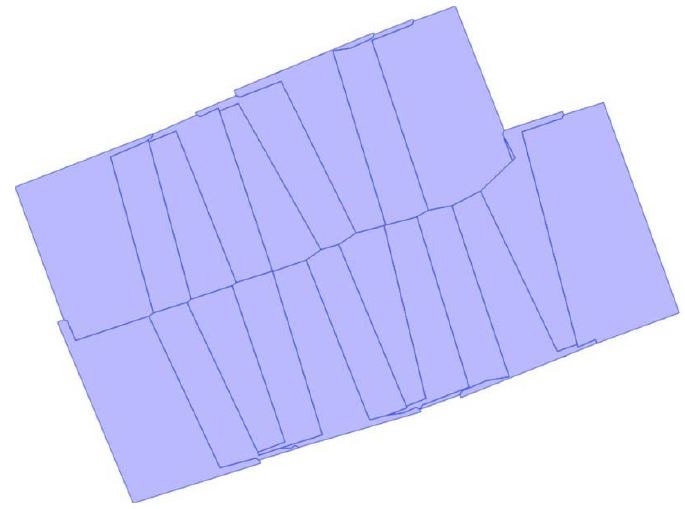
Figure 15. A different seamline network generated by the method in ERDAS IMAGE 2018 for a different image composite sequence.